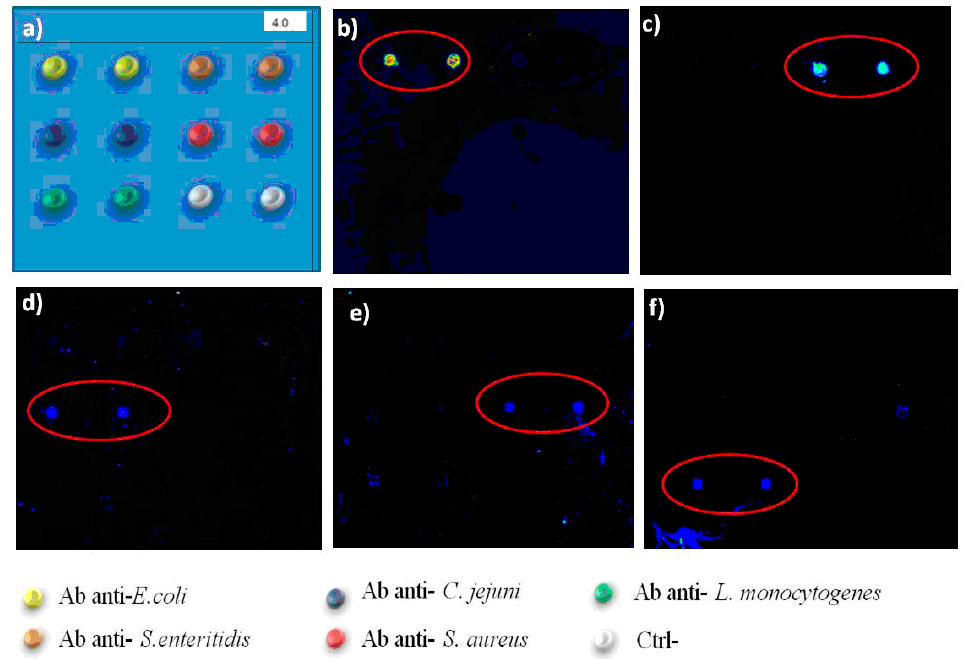
Figure 5. Assessment of performance of protein chips in detection of multiple bacterial species Left Upper line: Scheme of antibodies spotted in the x , y axis. Yellow: anti- E. coli Antibodies; orange: anti- Salmonella Abs; black: anti- C. jejuni Abs; green: anti- Listeria monocytogenes Abs; red: anti- S. aureus Abs. Size of the subarray area is 3 × 3 mm. Salmonella spp. were recognised by anti- Salmonella specific antibodies ( b ); E. coli ( a ) was detected in the anti- E.coli Ab spots. ( c ) C. jejuni was recognised by anti- C. jejuni Abs; ( d ) Listeria monocytogenes was recognised by anti- Listeria Abs; ( e ) Staphylococcus aureus was recognised by anti- S. aureus Abs. Experiments were repeated at least three times. Scale in mm. Each subarray area was 3 × 3 mm.